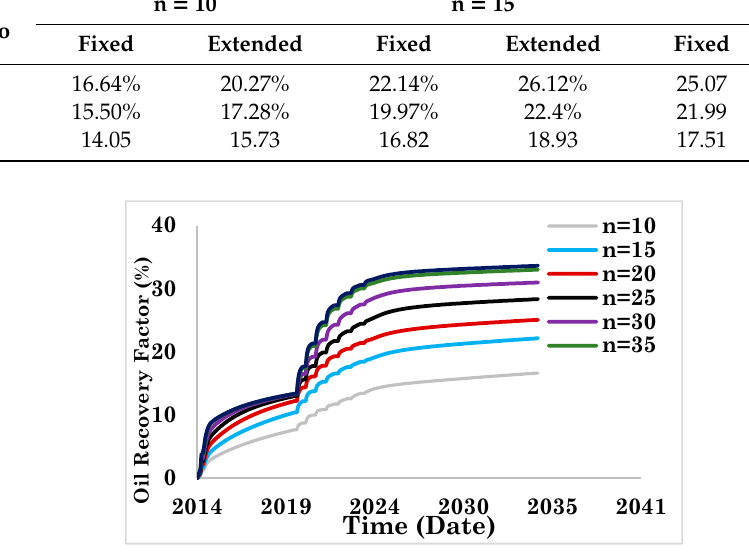
Figure 10. C 2 H 6 Injection (Fixed Cycle Size) 38 API Oil.